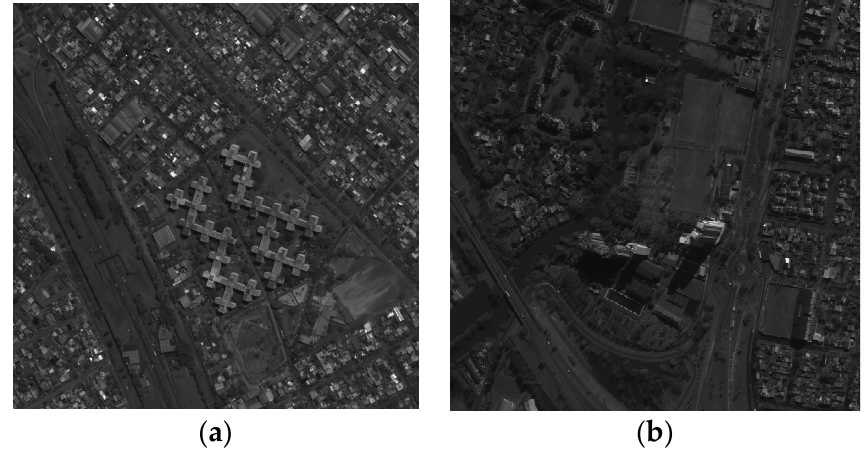
Figure 9. WorldView-3 image: ( a ) test site 1, ( b ) test site 2.